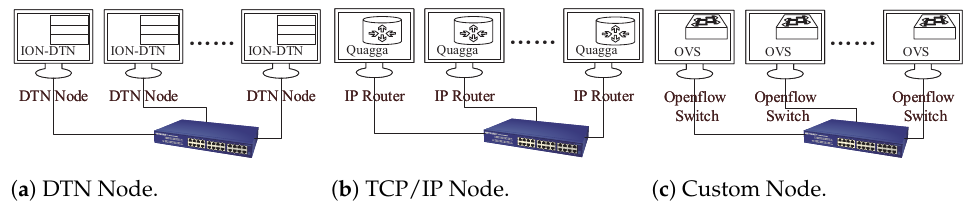
Figure 4. Different types of emulation